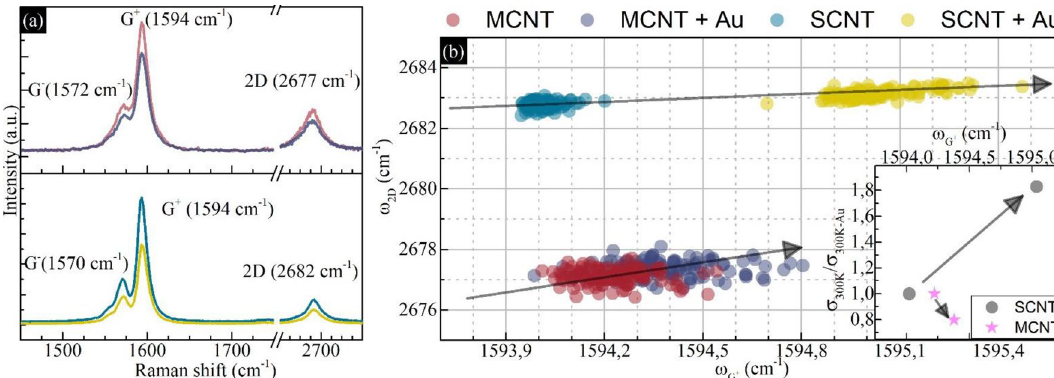
Figure 2. ( a ) The representative spectra collected from mCNT, mCNT + Au, sCNT and sCNT + Au. ( b ) Correlation of 2D mode and G + mode positions with an inset consisting of normalized changes of conductivity versus G + mode